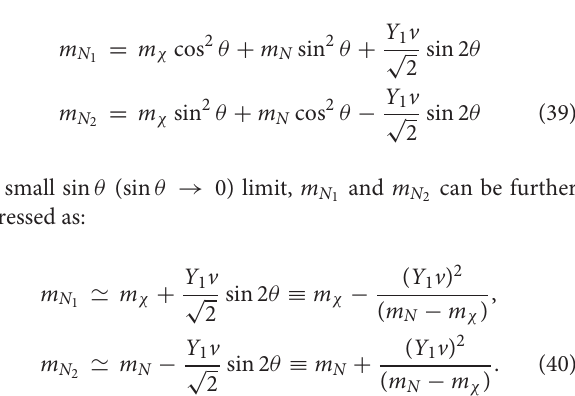
FIGURE 13 | SI direct detection cross-section σ SI as a function of DM mass m N 0 f N 0.01,0.1,1 are shown in Red, Blue, and Green color, respectively. Dashed and solid lines corresponds to different values of the heavy Higgs m H { = } GeVs, respectively. The bound from LUX 2017 and XENON1T 2018 are shown. TABLE 2 | Quantum numbers of additional dark sector fermions and that of Higgs Z 2 . SU (3) C SU (2) L U (1) Y under G ≡ × × ×